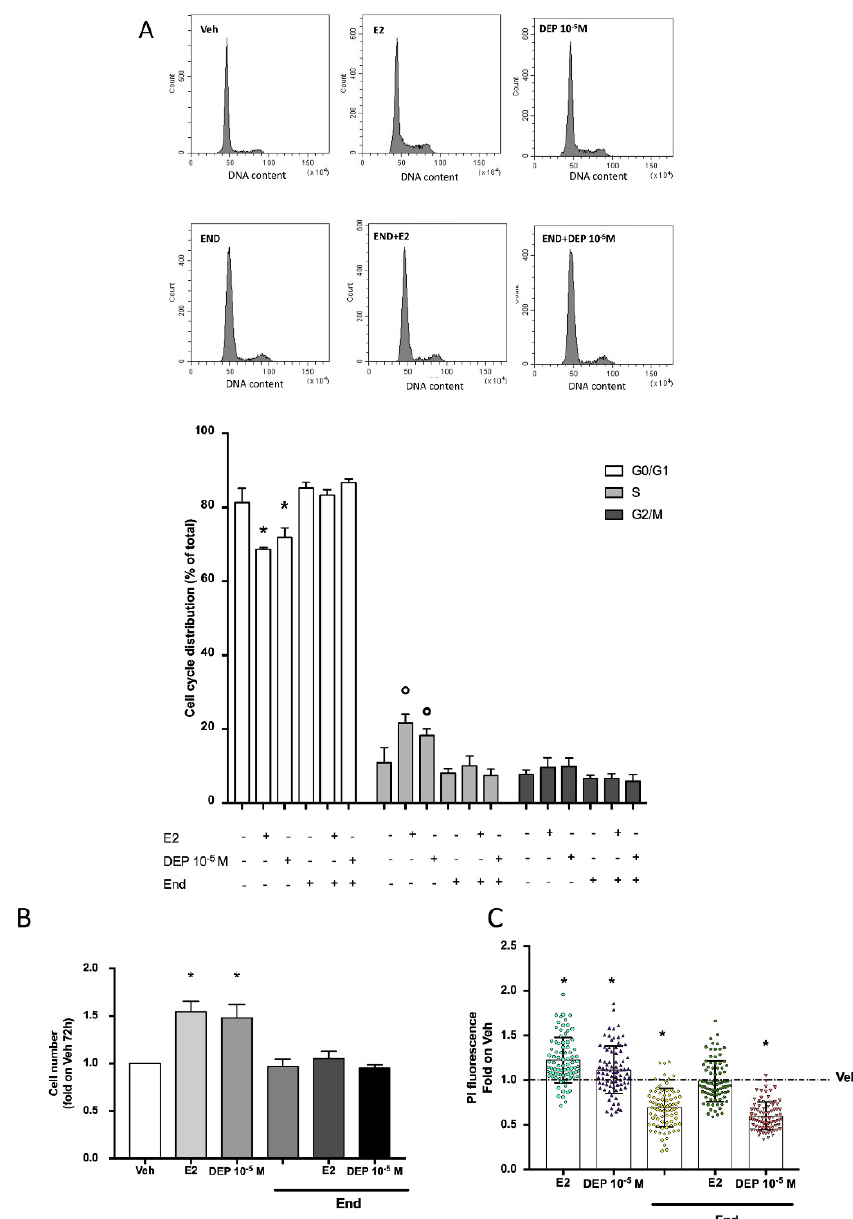
Figure 4. The effect of DEP on ER α -dependent DNA synthesis, cell cycle progression, and proliferation. Cell cycle analysis in MCF-7 cells treated with DEP 10 − 5 M for 24 h with or without pre-stimulation with End (10 − 6 M, 1 h before). Upper panels show flow cytometry analysis for cell cycle distribution of MCF-7 cells under different treatment conditions. The bottom panel shows the percentage of cells in G0/G1, S, and G2/M phases with respect to different stimulations. Histograms are representative of at least three independent experiments ( A ). Viable cell number ( B ) and analysis of total DNA content obtained from propidium iodide (PI) assay ( B ) of MCF-7 cells treated with DEP 10 − 5 M for 72 h in the presence or absence of End pre-treatment (10 − 6 M, 1 h before). Data are shown as fold of increase in Vehicle condition represented by the blank column ( B ) or as the dotted line ( C ). E2 stimulation with or without End pre-stimulation was used as positive control. p < 0.01 was determined by the ANOVA test followed by the Bonferroni post-test vs. G0/G1 phase Veh (-,-,-) and Veh ( B , C ) (*) or vs. S phase Veh (-,-,-) ( ◦